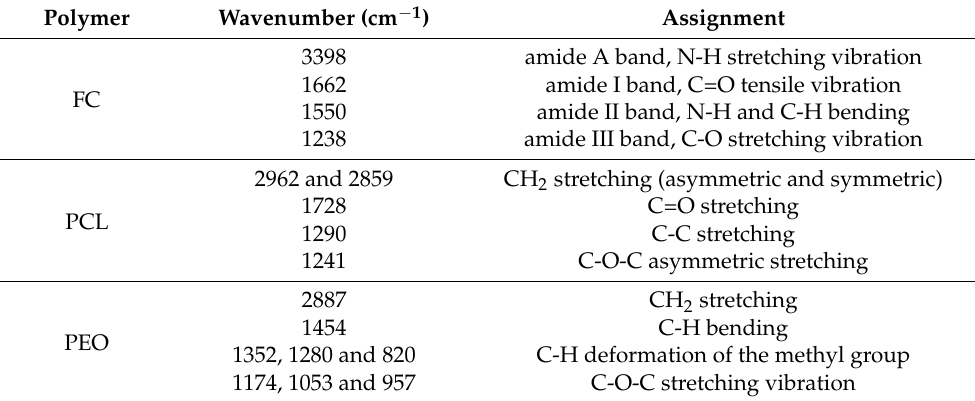
Table 2. Tentative assignments of FTIR Peaks for type I collagen, PCL, and PEO.